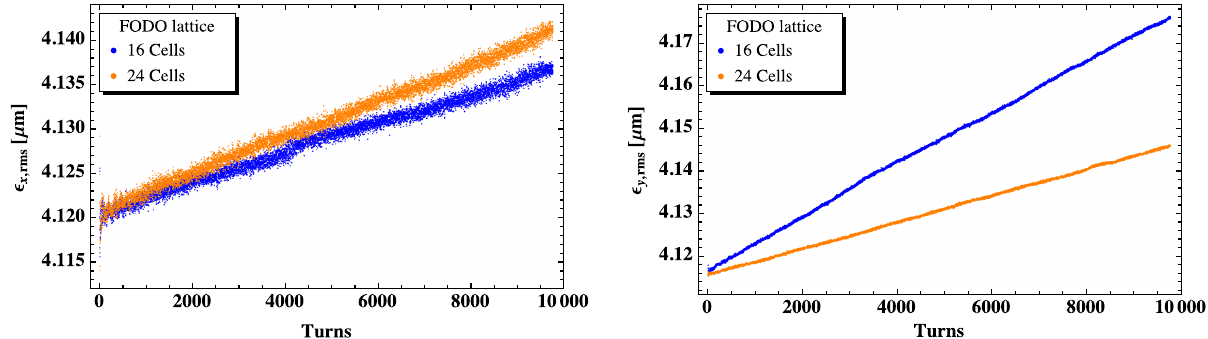
FIG. 18. Time evolution of horizontal (top) and vertical (bottom) rms emittance for the regular FODO lattices with 16 and 24 cells.